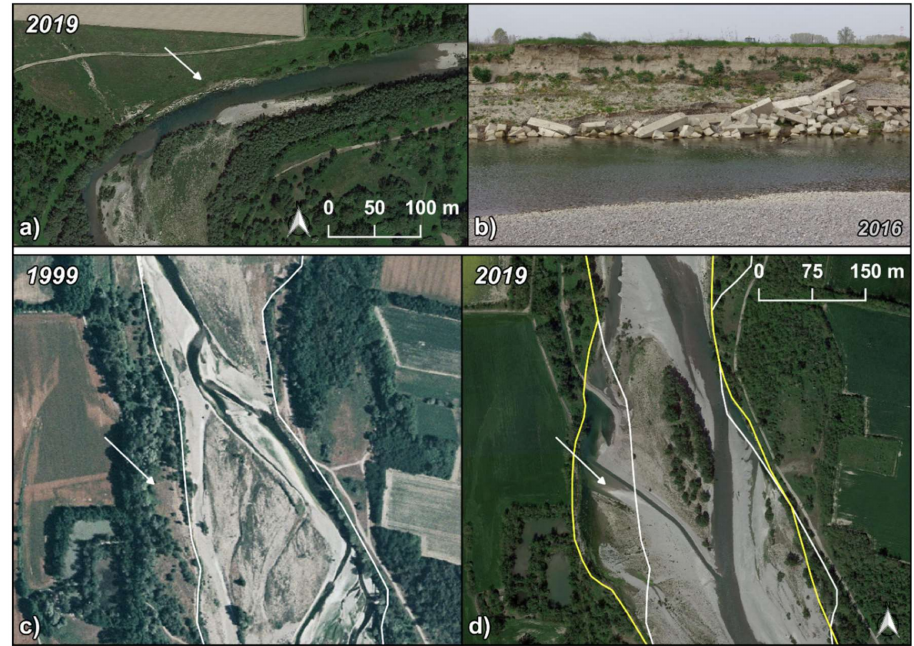
Figure 9. Examples of active channel widening associated with distinct lateral-erosion processes; see the text for explanation. ( a , b ) High and steep bank presenting a collapsed defense structure; the arrow in ( a ) indicates the location of ( b ) (photo by A. Mandarino); ( c , d ) The arrow in ( c ) indicates the in-channel modern floodplain formed before 1999 that has been eroded over the last twenty years ( d ); the white and yellow lines correspond to the 1999 and 2019 banks,